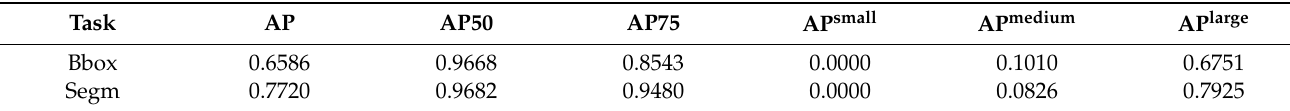
Table 3. Mask -RCNN performance